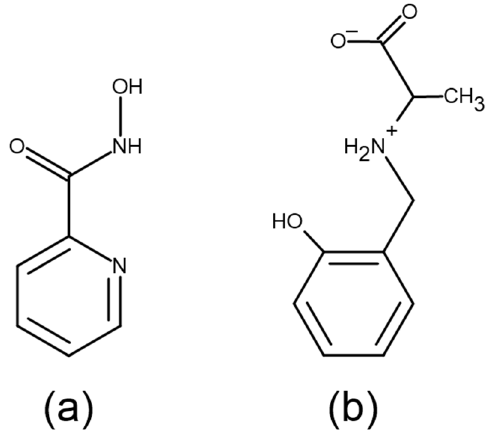
Figure 1. Ligand structures ( a ) 2-picolinehydroxamic acid, PicHA (LH) ( b ) N -(2-hydroxybenzyl)alanine, AlaSal (L’H 2 ).